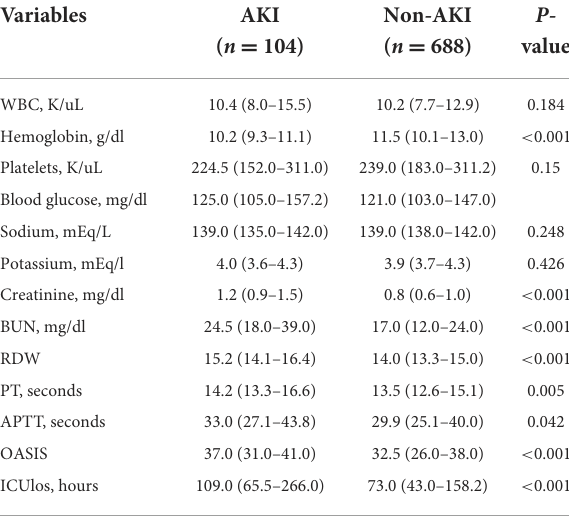
TABLE 2 Characteristics at baseline between AKI and non-AKI in train